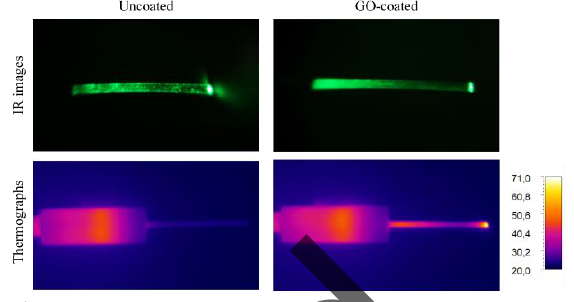
Fig 5. IR images and thermographs of uncoated and GO-coated PMMA